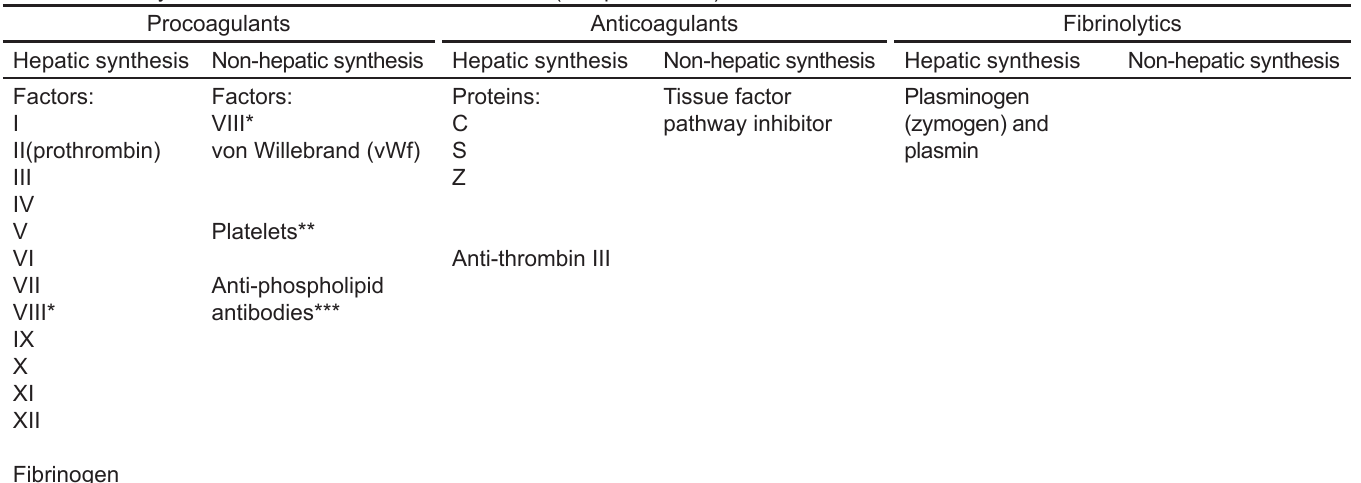
Table. Summary of factors associated with hemostasis (compiled 9,10,24,31